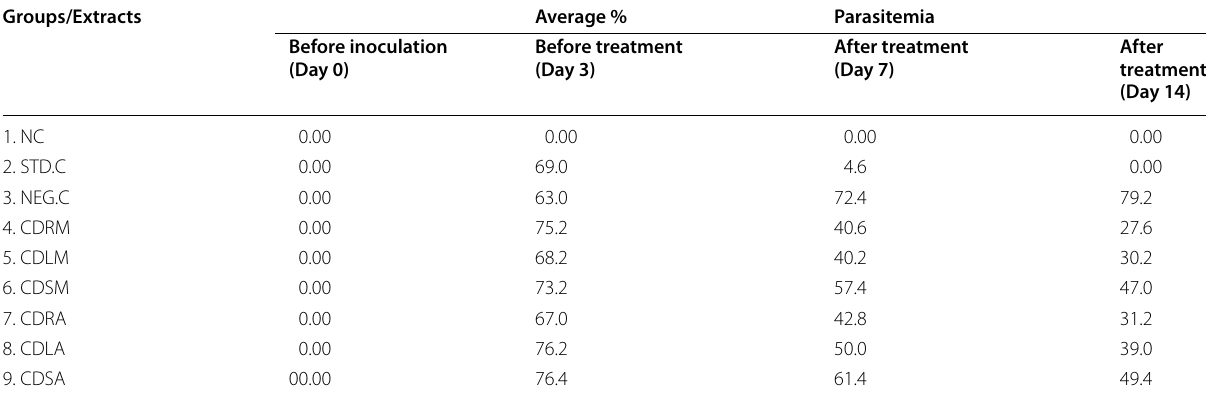
NC, normal control; NEG.C, negative control; STD.C, standard control; CDRM, C. dependens root methanol; CDLM, C. dependens leaves methanol; CDSM, C. dependens stem methanol; CDRA, C. dependens root aqueous; CDLA, C. dependens leaves aqueous; CDSA, C. dependens stem aqueous Table 3 Effects of crude aqueous and methanolic extracts of leaves, stem and roots of Chasmanthera dependens on percentage body weight and rate of survival of Plasmodium berghi infected male Swiss albino mice